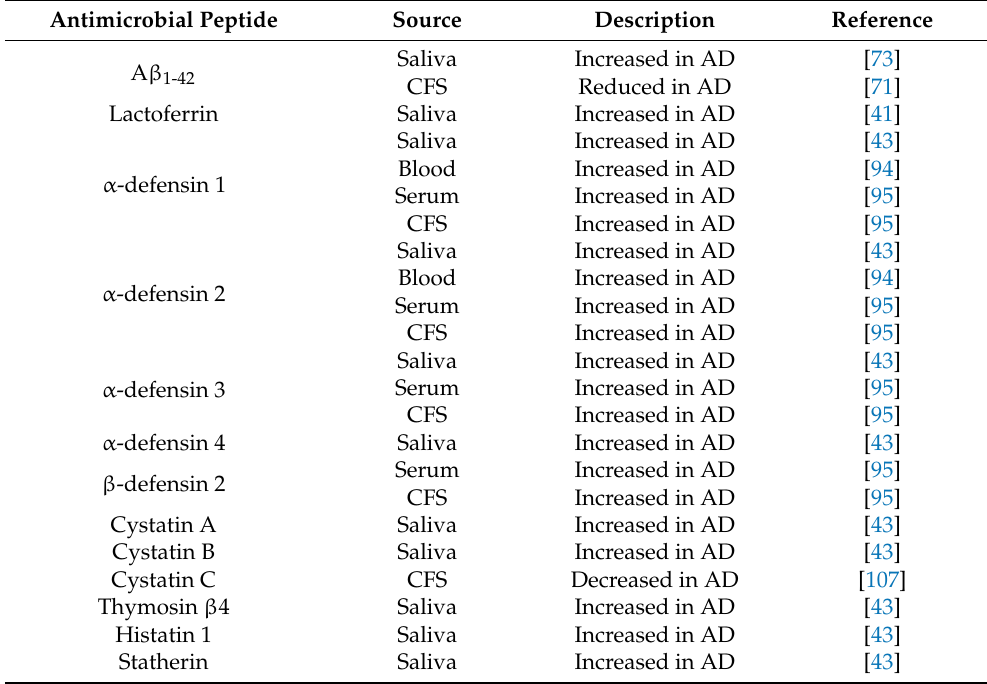
Table 1. AMP biomarkers in AD. Biomarkers are listed along with their source and relationship to AD. Antimicrobial